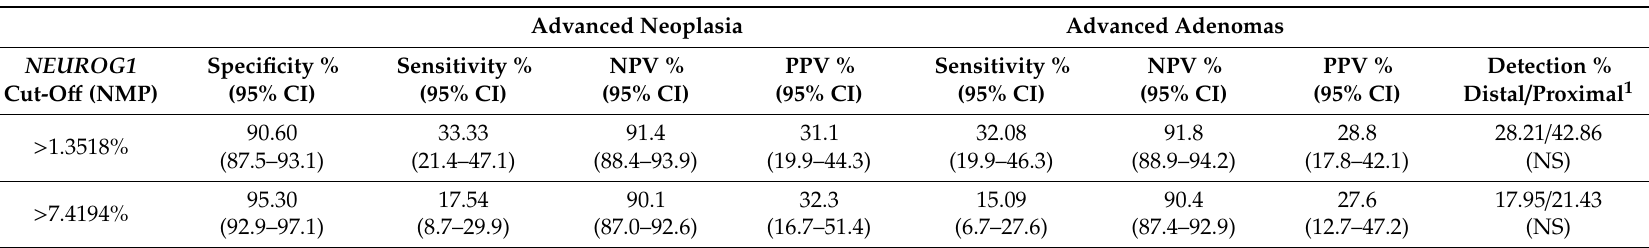
Table 3. Diagnostic performance of serum NEUROG1 methylation for the detection of advanced neoplasia and advanced adenomas in the screening cohort.